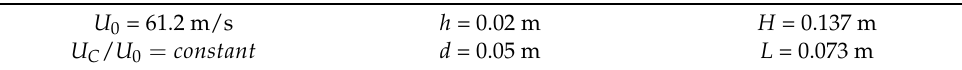
Table 3. Model parameter of Lafon’